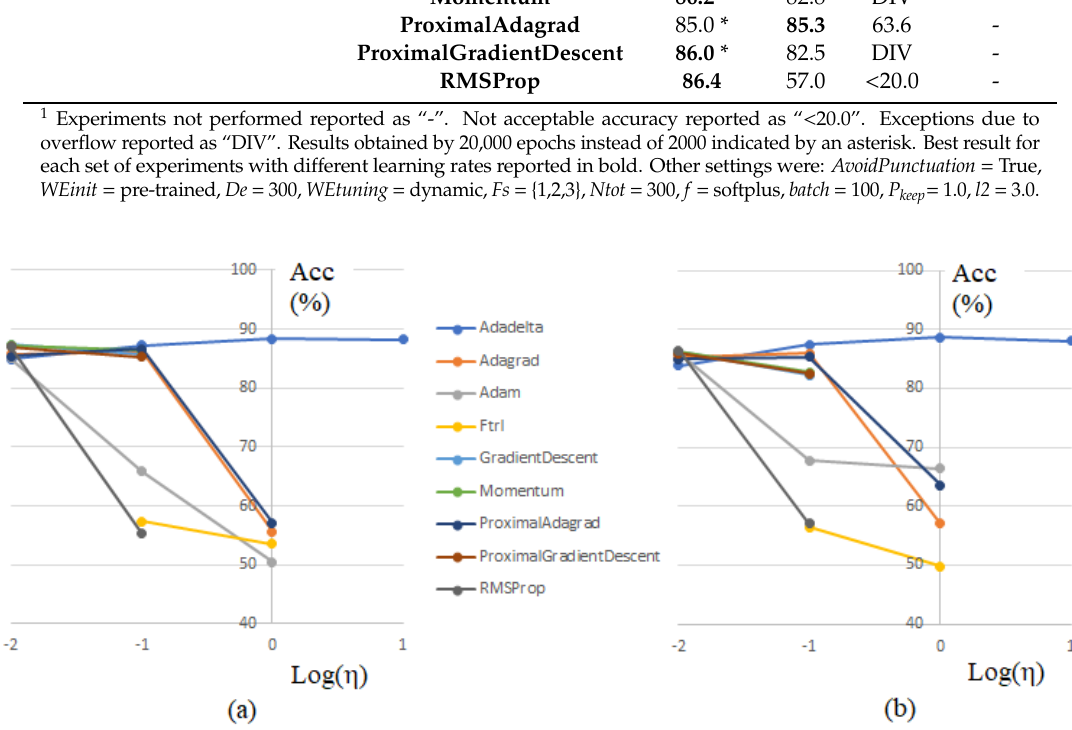
Figure 9. Testing accuracy obtained by different weights updating rules and different learning rates, for English (a) and Italian (b).